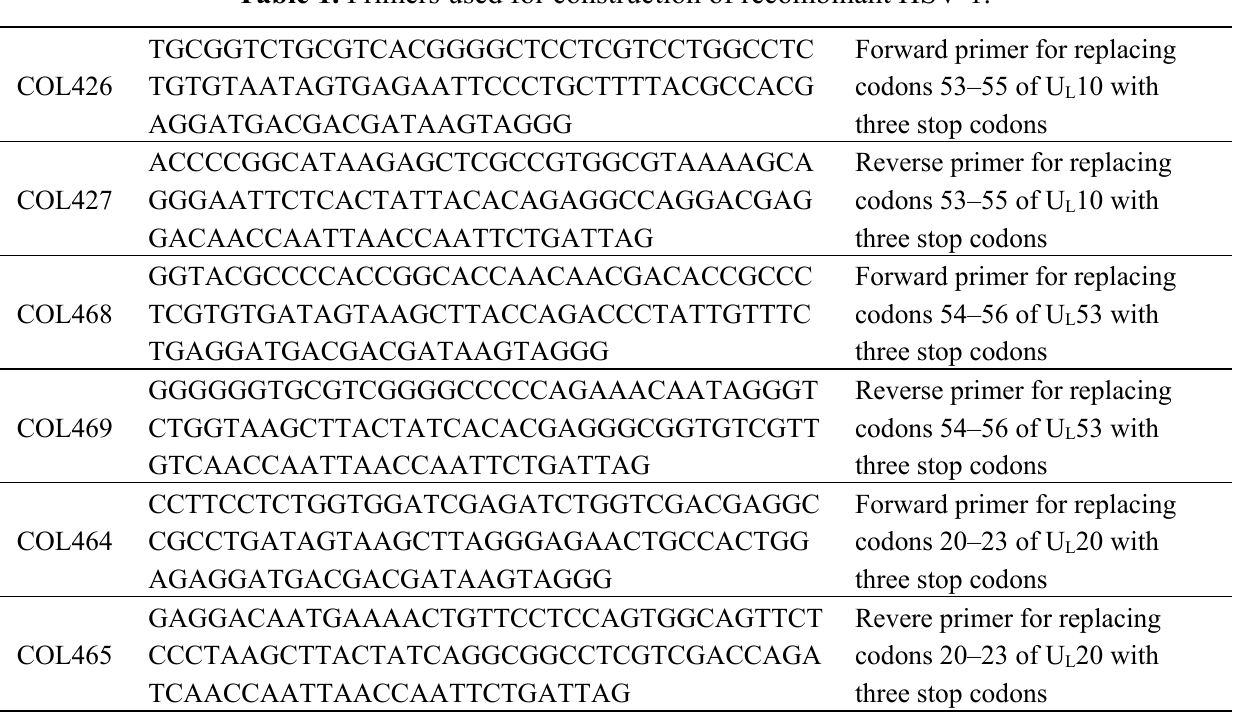
Table 1. Primers used for construction of recombinant